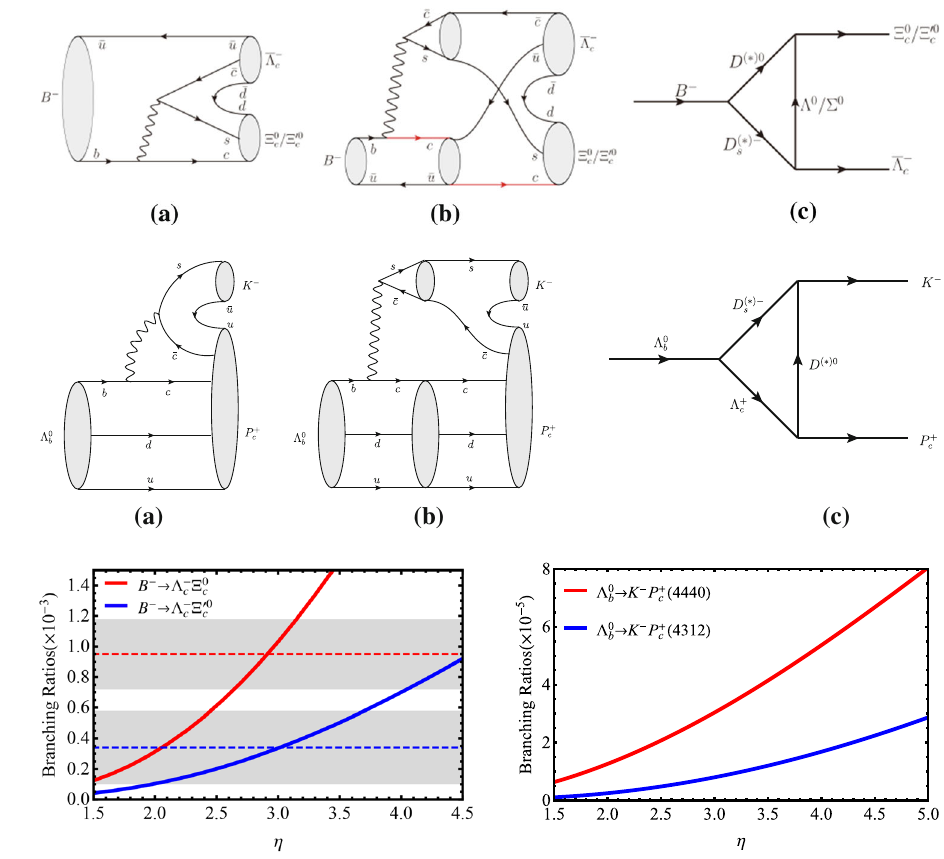
Fig. 4 The topological diagram, the quark-level diagram and the hadron-level triangle diagram of − (cid:3) ( (cid:3) ) 0 B − → (cid:2) c within c rescattering mechanism are given from the left to the right, respectively Fig. 5 Similar to Fig. 4 but for (cid:2) 0